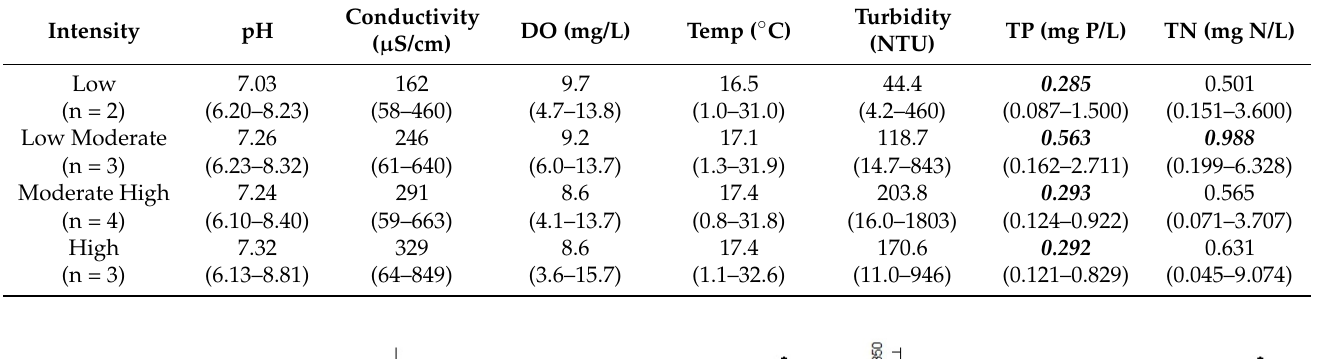
Table 2. Mean values and range for physicochemical water quality (pH, conductivity, dissolved oxygen (DO), water temperature), turbidity, and total nutrient parameters (total phosphorus (TP), total nitrogen (TN)) measured from October 2017 to September 2020 at four agricultural intensities of